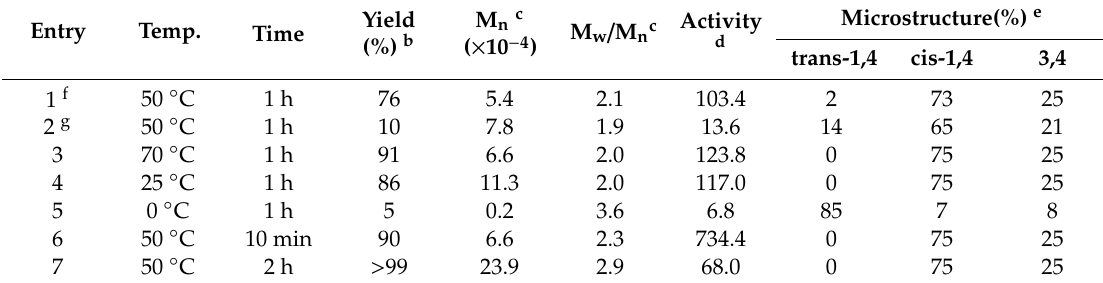
Table 3. E ff ects of temperature and amount of cocatalyst by complex V3 a .